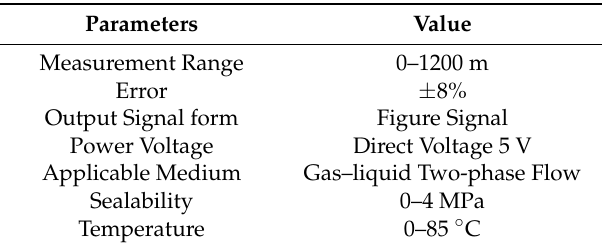
Table 1. Measurement index of working level